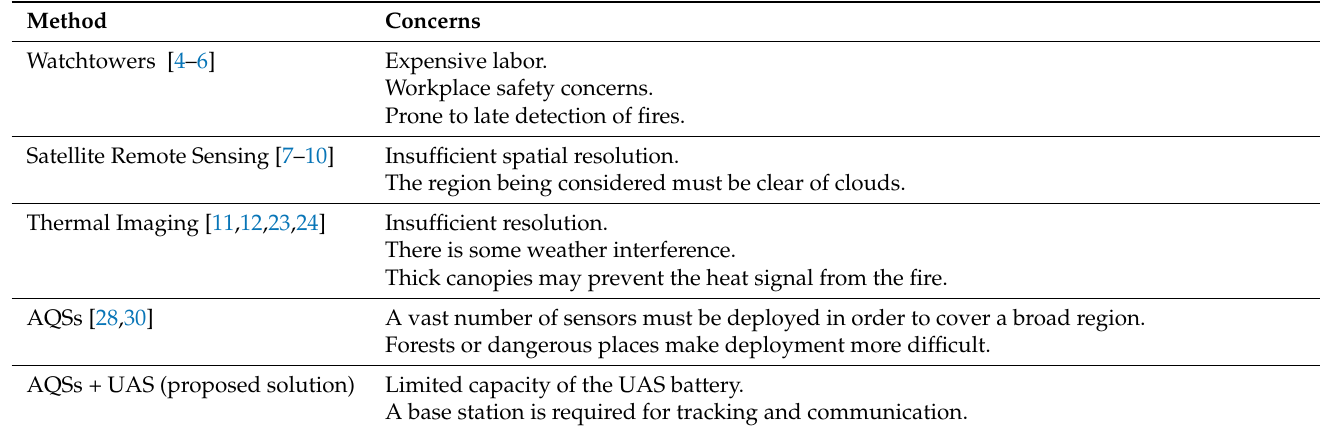
Table 1. Comparison between existing and introduced wildfire